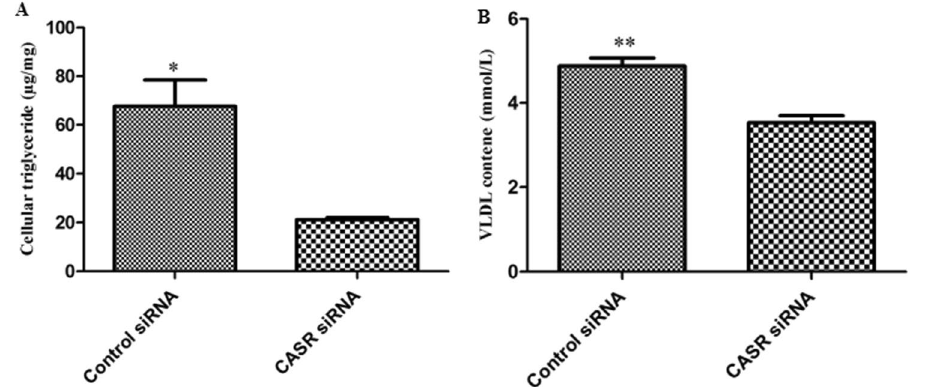
Figure 6. Changes in cellular TAG and extracellular VLDL after transfected with control or CASR siRNA in bovine hepatocytes. ( A ) TAG content. ( B ) Extracellular VLDL content. Values are presented as the means ± S.E.M. “ * ”Represents significant differences P < 0.05; “ ** ”represents significant differences P <